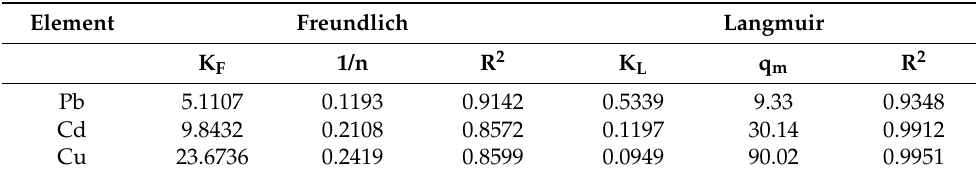
Table 3. Parameters of Freundlich and Langmuir isothermal models for Pb, Cd and Cu after GBC